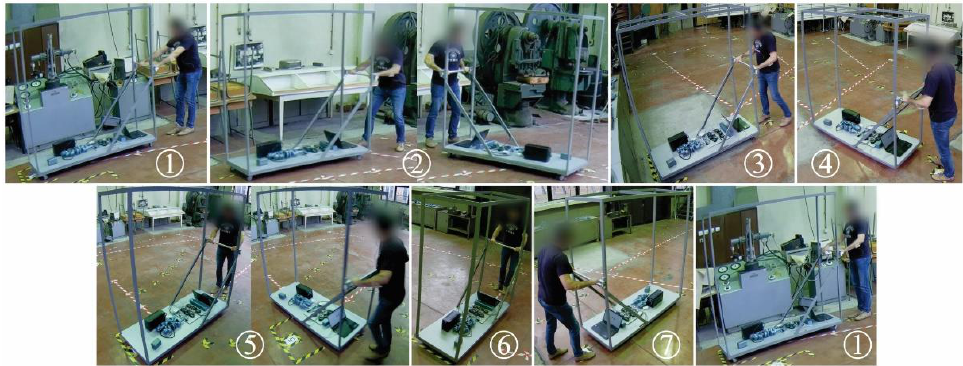
Figure 4. Trolleys’ and operators’ positions during sessions illustrated in Figure